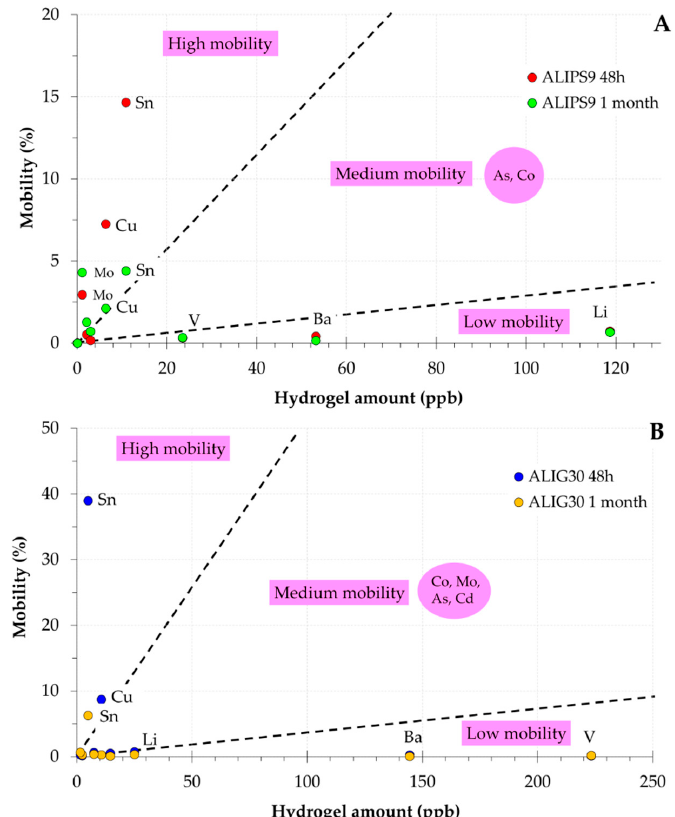
Figure 3. Element mobility (%) versus the total amount of element in ALIPS9 ( A ) and ALIG30 ( B ). Only mobile elements are shown. mobile elements are